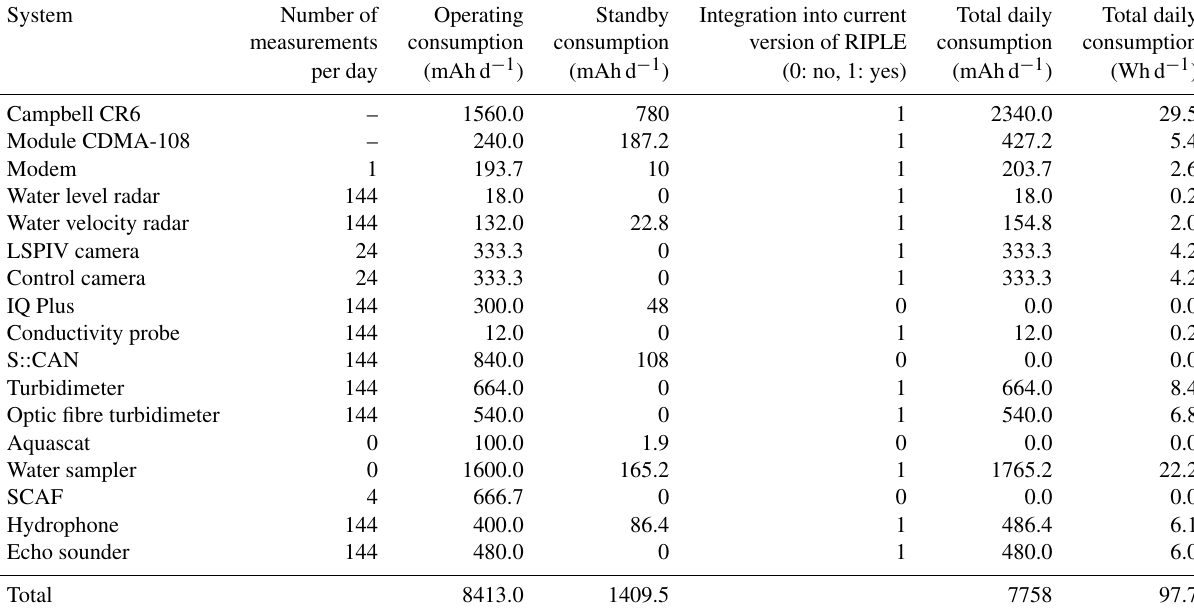
Table 2. Power balance of instruments integrated into the RIPLE